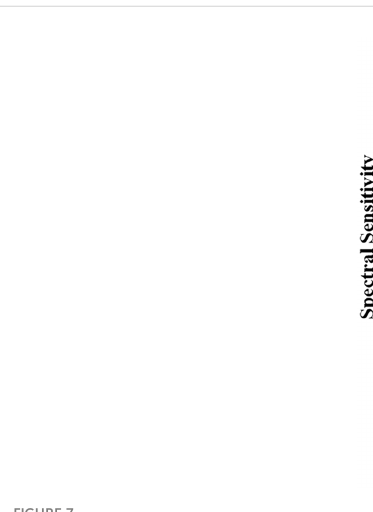
FIGURE 7 Spectral sensitivity of jujube spider mite infestation in each waveband.